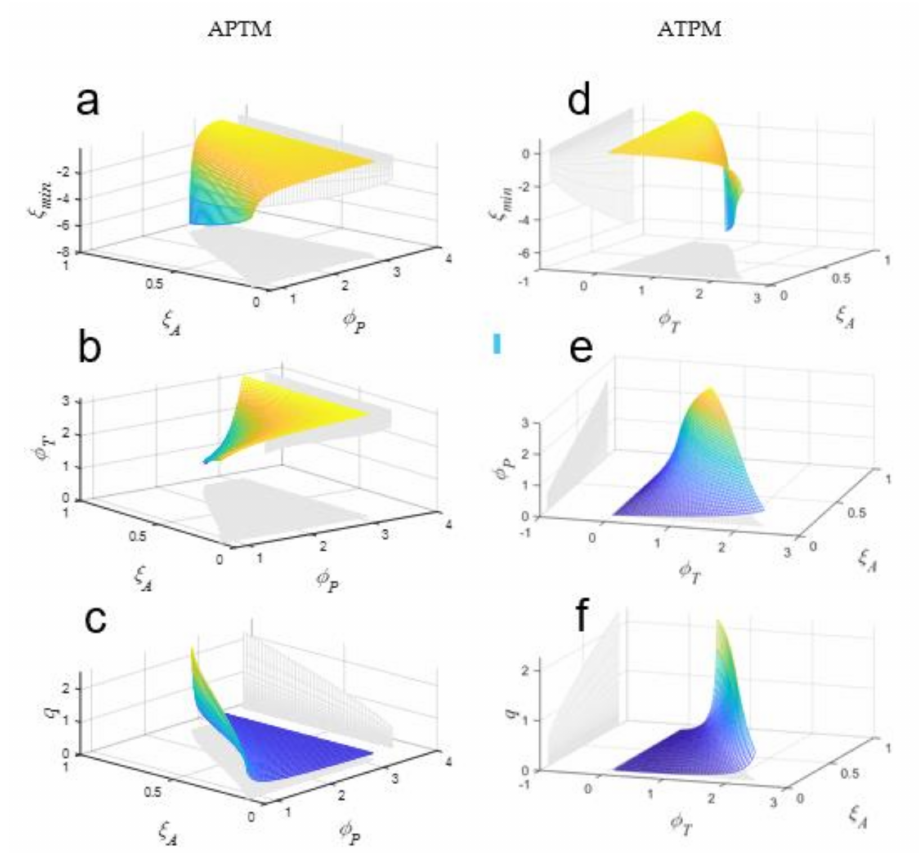
Figure 5. Results of the analytical model in nondimensional quantities for the steady state behavior of APTM ( a − c ) and ATPM ( d − f ). Sub-figures ( a , d ): ξ min the minimum position (see also Figure 4), takes only negative values, particularly for APTM. The strong fall to very negative values is a resonance effect and is correlated to the flow rate increase shown by q 1 in sub-figures ( c , f ). The duration of the last phase in terms of the phase angles ϕ T and ϕ P is given in sub-figures ( b , e